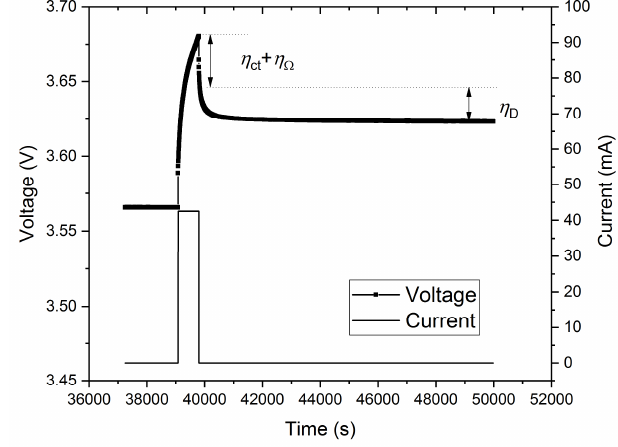
Figure 3. Charging (0.5 C rate) pulse followed by a relaxation time of 3 h. Batteries 2020 , 6 , x FOR PEER REVIEW